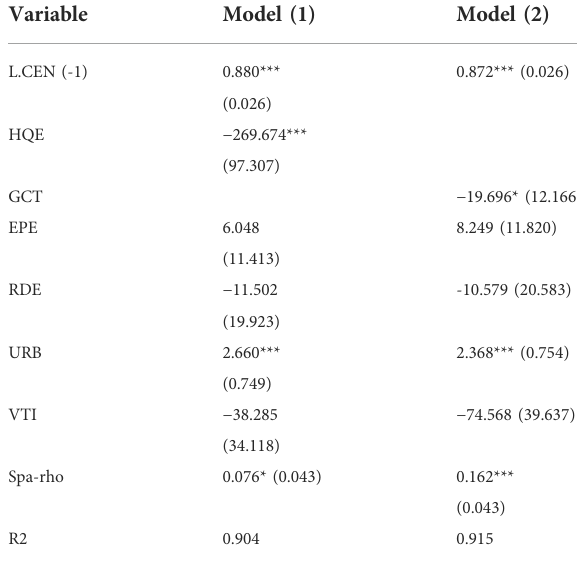
FIGURE 6 Partial derivative of in fl uence of green credit on carbon emissions.